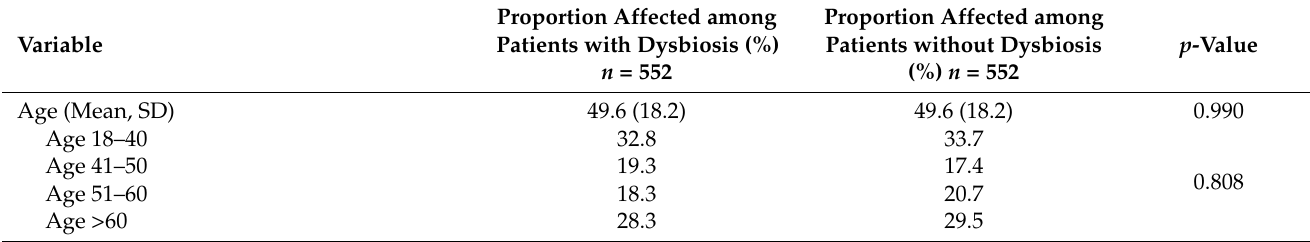
Table 1. Basic characteristics of the study sample (after 1:1 propensity score matching by sex, age, Charlson comorbidity index, and yearly number of visits during